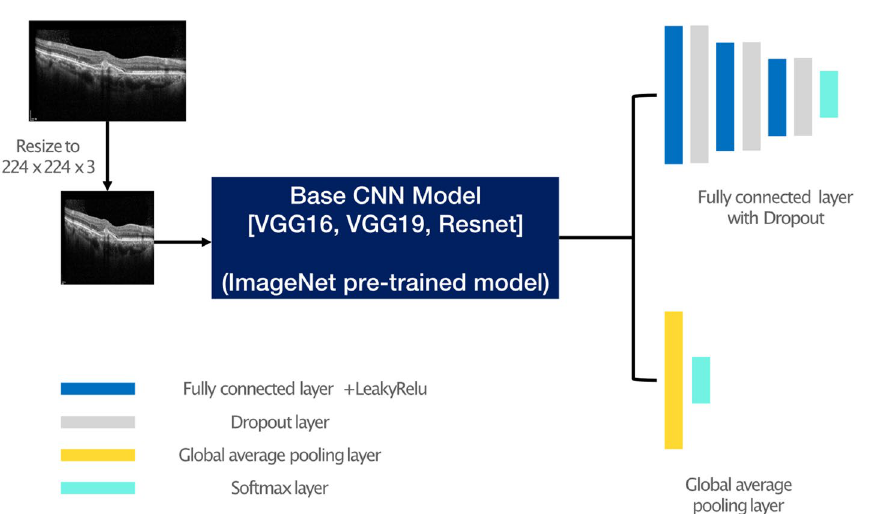
Figure 5. Entire process of extracting lesion cuts from 25 SD-OCT scan images. Initially, Retina expert (DDH) extracted lesion cuts from the 25 SD-OCT images for patient. Next, we selected N (i.e., 0 ≤ N ≤ 5) lesion cuts between the 11th and 15th central regions. Finally, we randomly selected 10-N non-centered lesion cuts. Therefore, up to 10 images were selected per patient for this study.